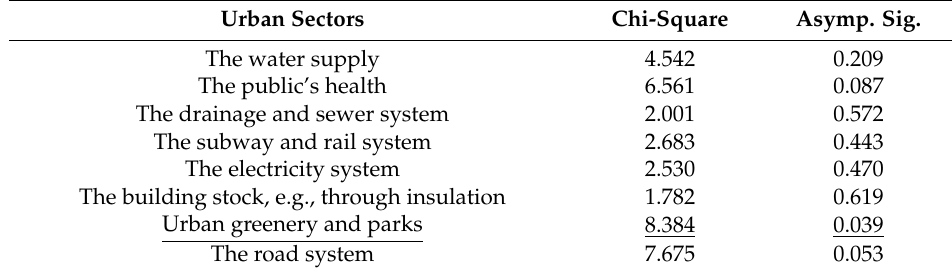
Table 4. Results of Kruskal–Wallis H-Test in regard to the importance of adaptation to heat waves for different urban sectors. The underlined text shows the significant differences between income groups with p -value less than 0.05.